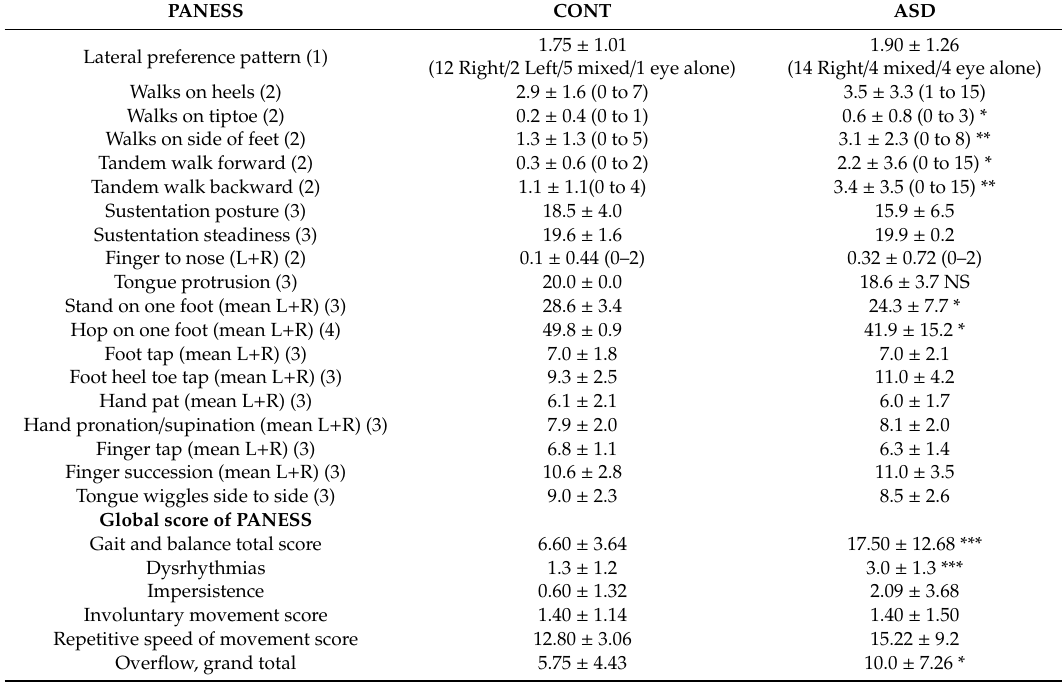
Table 3. Motor assessment by the Physical and Neurological Exam for Subtle Signs (PANESS)